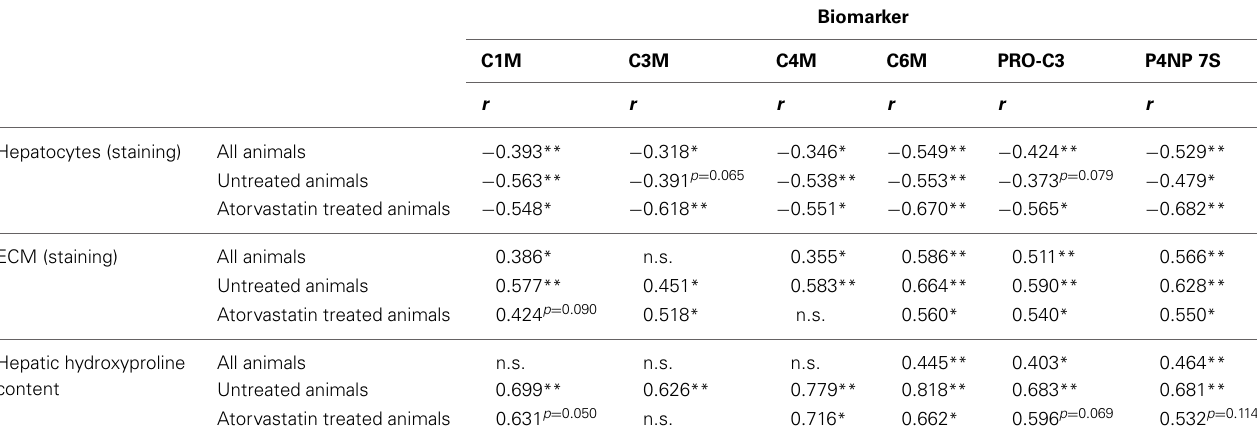
Table 2 | Correlations of hepatic histology and function with ECM markers.